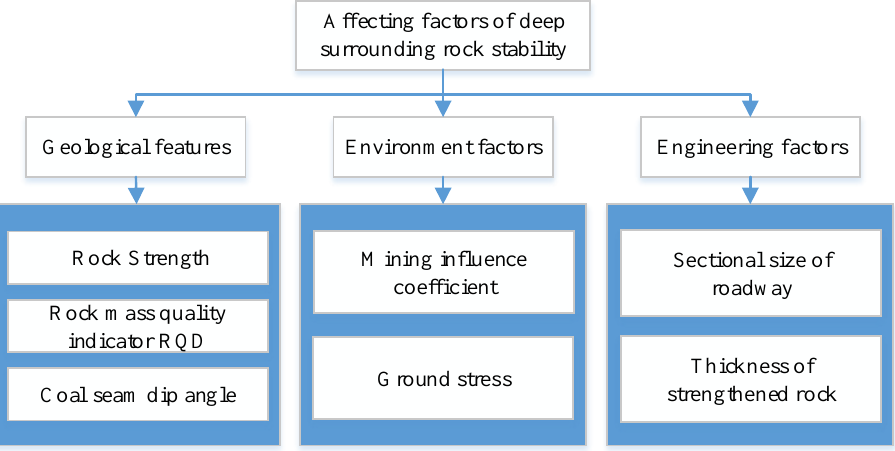
Figure 3. Deep surrounding rock stability evaluation index system. Table 7. The normalized weights of key factors.